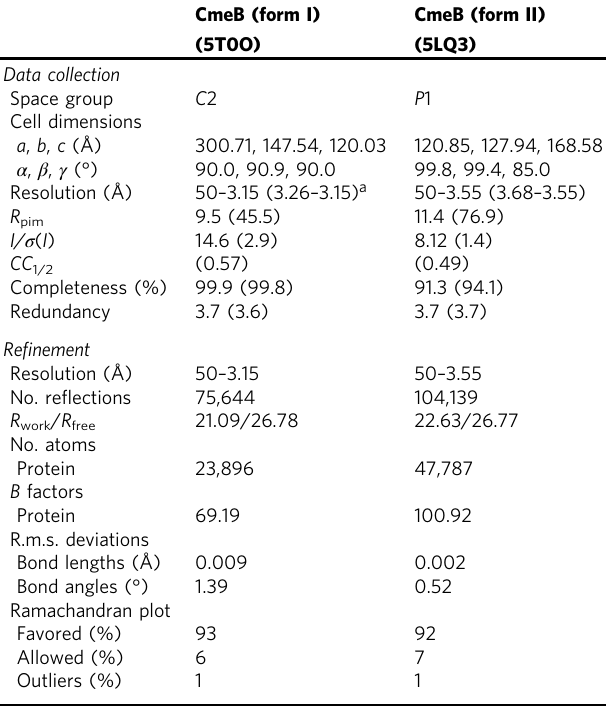
Table 1 Data collection and re fi nement